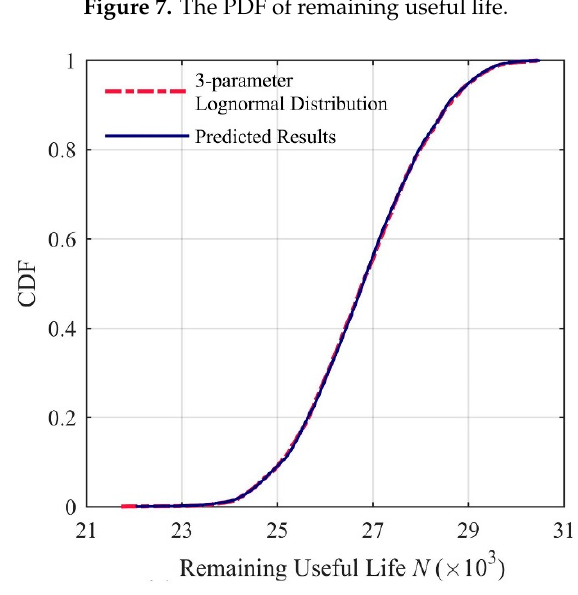
Figure 8. The CDF of remaining useful